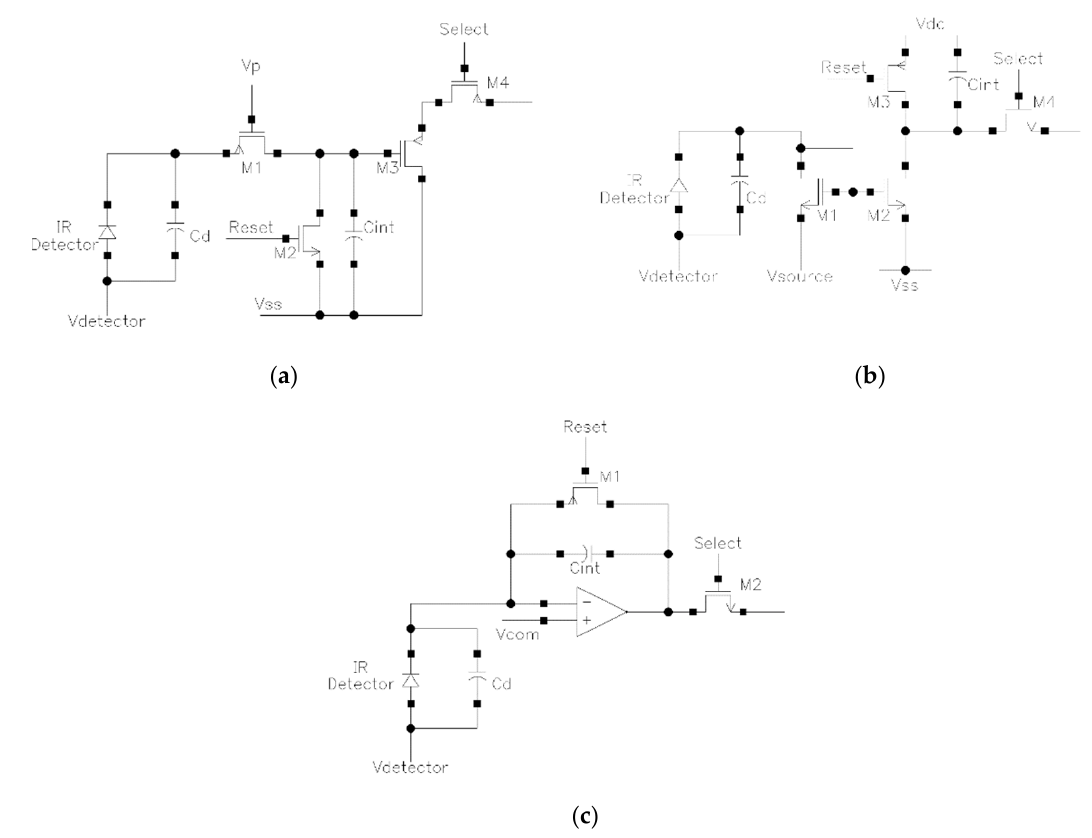
Figure 8. Structures of read-out circuit configuration: ( a ) direct injection (DI), ( b ) gate modulation input (GMI), and ( c ) capacitive transimpedance amplifier (CTIA).